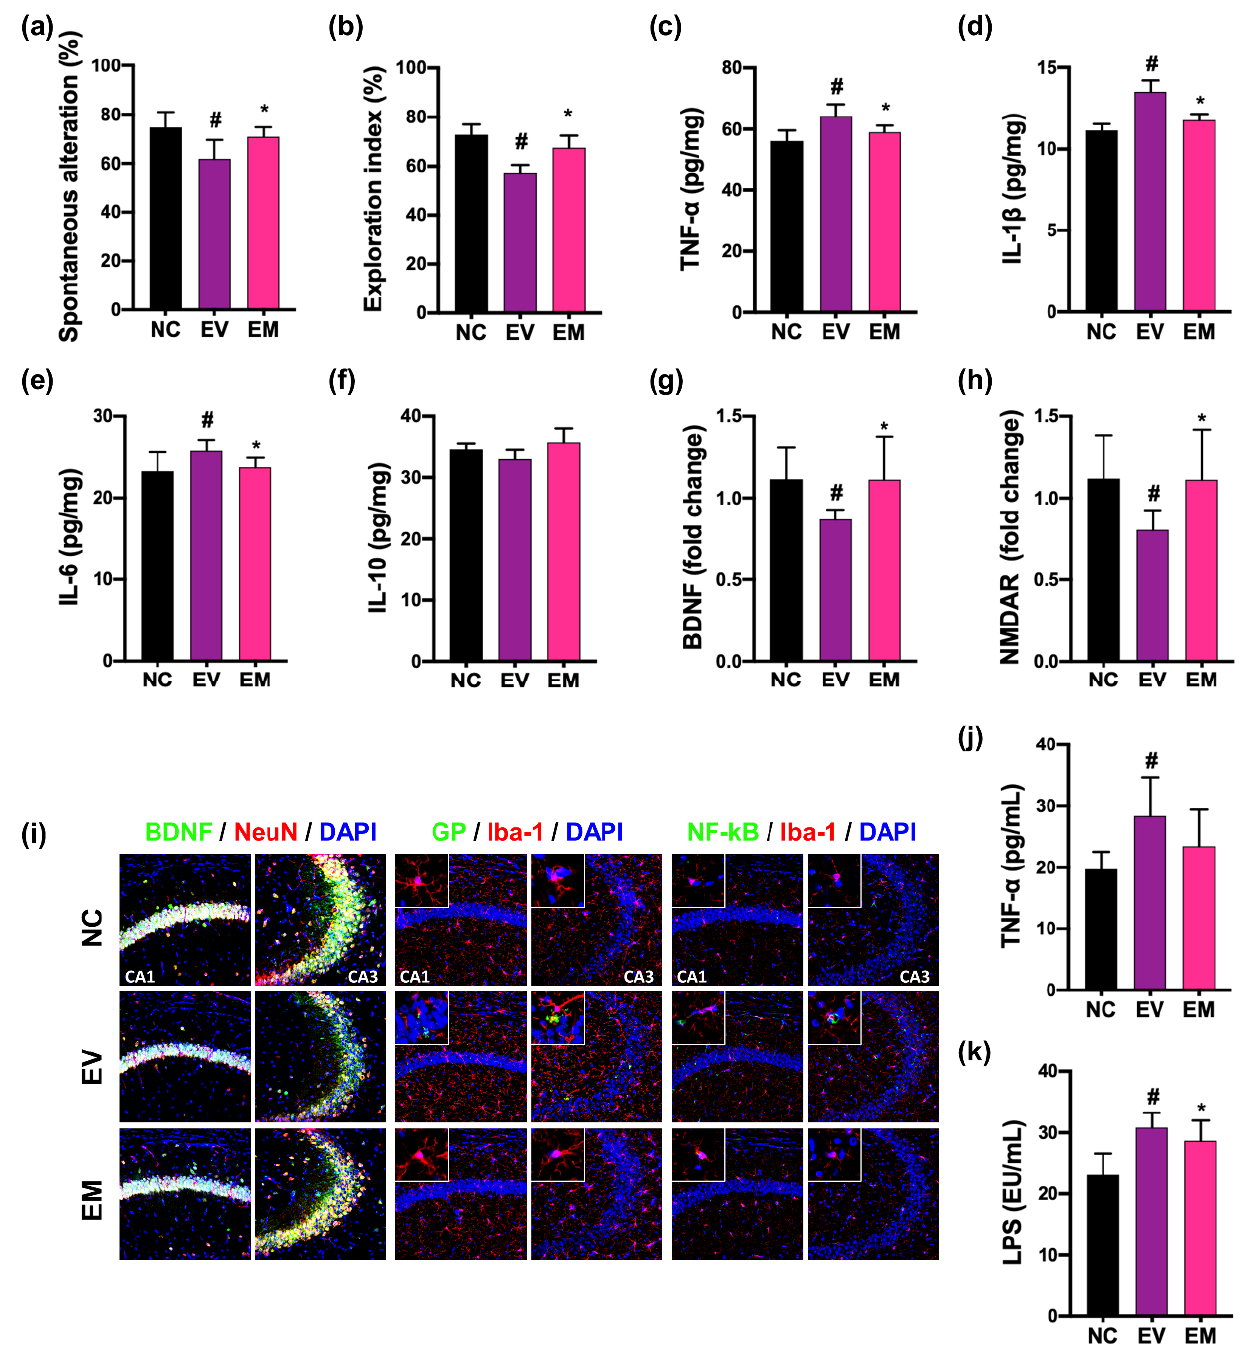
Figure 6. NKc alleviated pEVs-induced CI in mice. Effect on spontaneous alternation ( a ) and exploration ( b ). Effect on the hippocampal expression of TNF- α ( c ), IL-1 β ( d ), IL-6 ( e ), IL-10 ( f ), BDNF ( g ), and NMDAR ( h ) and populations of BDNF + NeuN + cells, GP + Iba1 + , and NF- κ B + Iba1 + cells ( i ). Effect on blood TNF- α ( j ) and LPS levels ( k ). Data were described as mean ± SD ( n = 6). # p < 0.05 vs. NC. * p < 0.05 vs. EV.